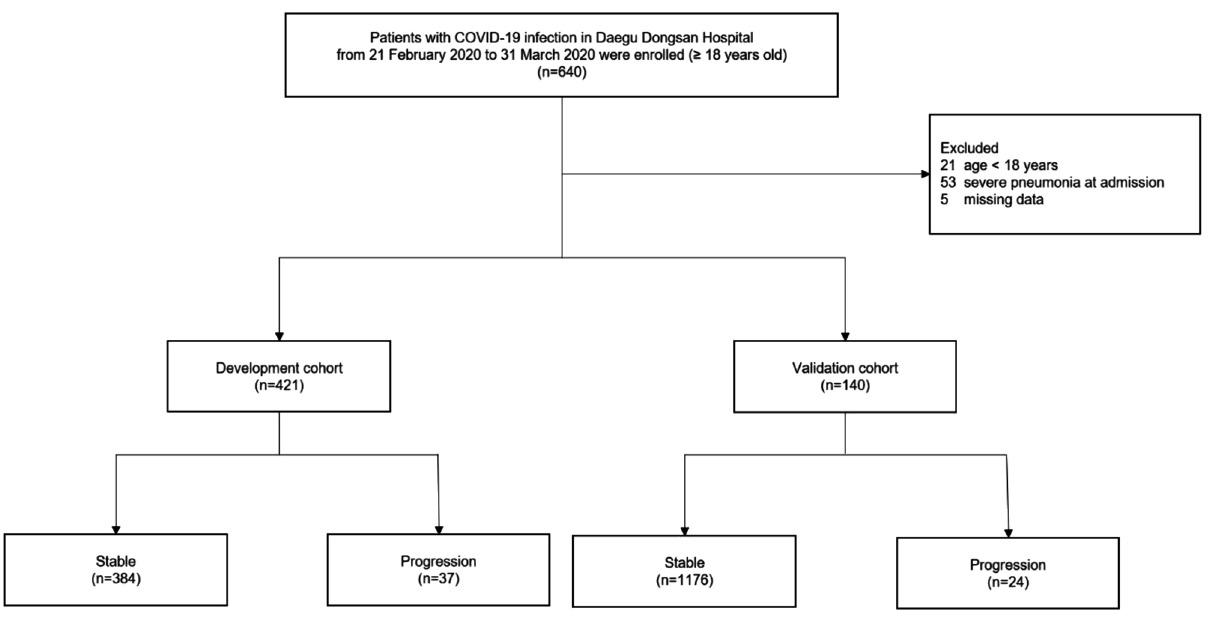
Figure 1. Selection of study